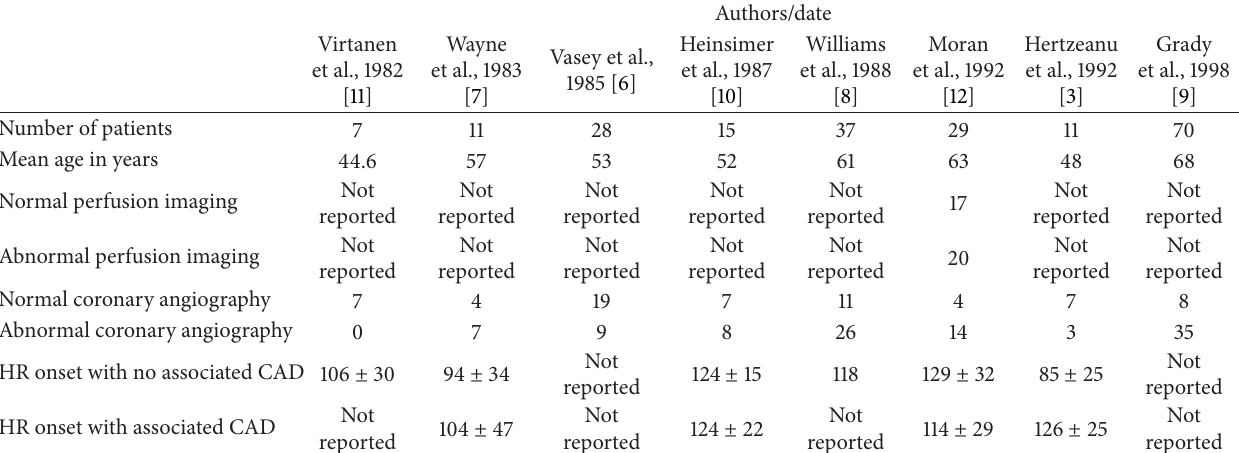
Table 1: All published case series of patients with exercise induced LBBB, with incidence and prevalence of coronary artery